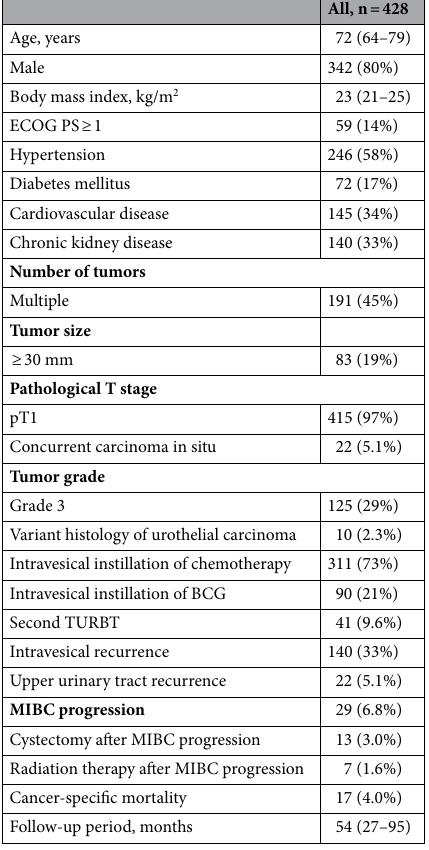
Table 2. Patients’ backgrounds. All data is presented as n (%) or median (interquartile range). ECOG PS, Eastern Cooperative Oncology Group performance status; BCG, bacillus Calmette-Guérin; TURBT, transurethral resection of bladder tumor; MIBC, muscle-invasive bladder